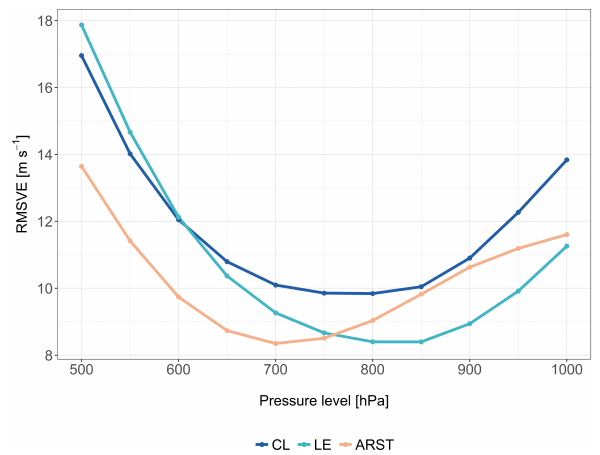
Figure 7. Calculated root mean square vector error (RMSVE) be- tween average advection components and wind zonal and merid- ional components obtained from Era-Interim reanalysis for pressure levels of 500–1000hPa for each synoptic